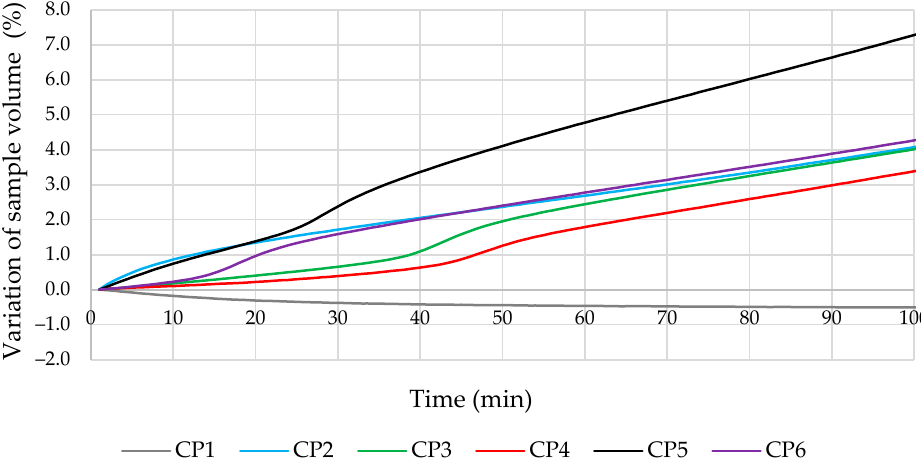
Figure 5. Test results for the change in specimen volumes due to hydrogen gas evolution.